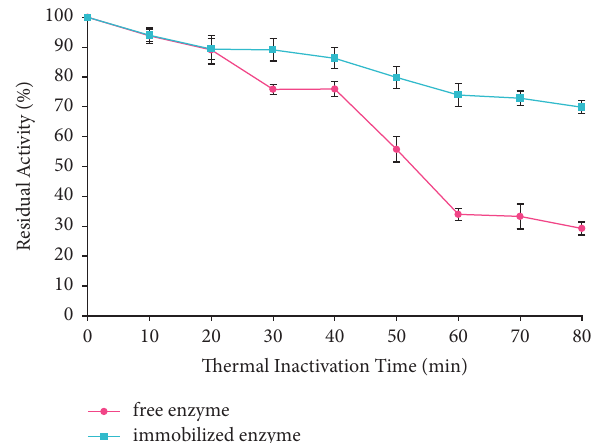
Figure 6: Thermal stability for free and immobilized enzymes. The data are presented as mean ± SD; n � 2; p ≤ 0 . 05. The error bars represent standard deviations from two replicates measurements. Figure 7: First-order inactivation rate plot for free and immobi-